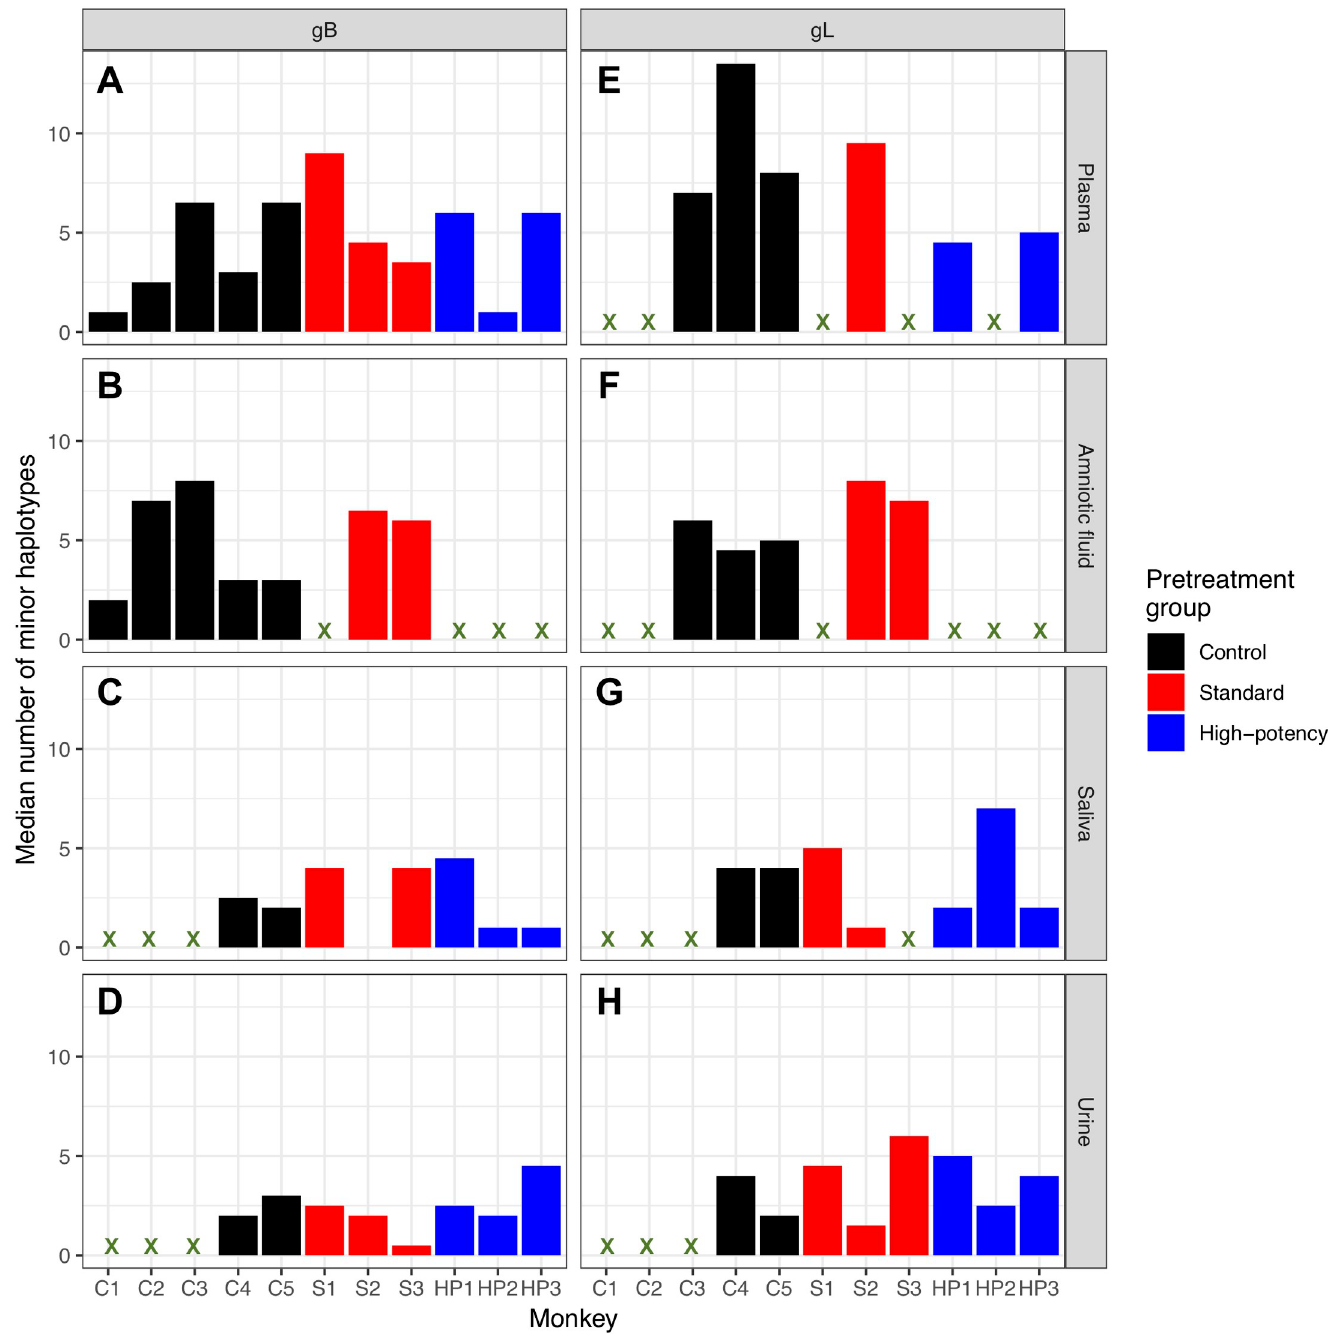
Fig 3. Median number of minor haplotypes, by locus, tissue, and pretreatment group. The panels A,B,C and D show the median number of gB minor haplotypes; panels E,F,G and H show the median number of gL minor haplotypes. Rows show tissues: plasma (A,E), amniotic fluid (B,F), saliva (C,G), and urine (D,H). Marker symbols correspond with those in S2 Fig. We found no significant differences in the median number of minor haplotypes across pretreatment groups for any tissue, at either locus (Mann Whitney test; p > 0.1).